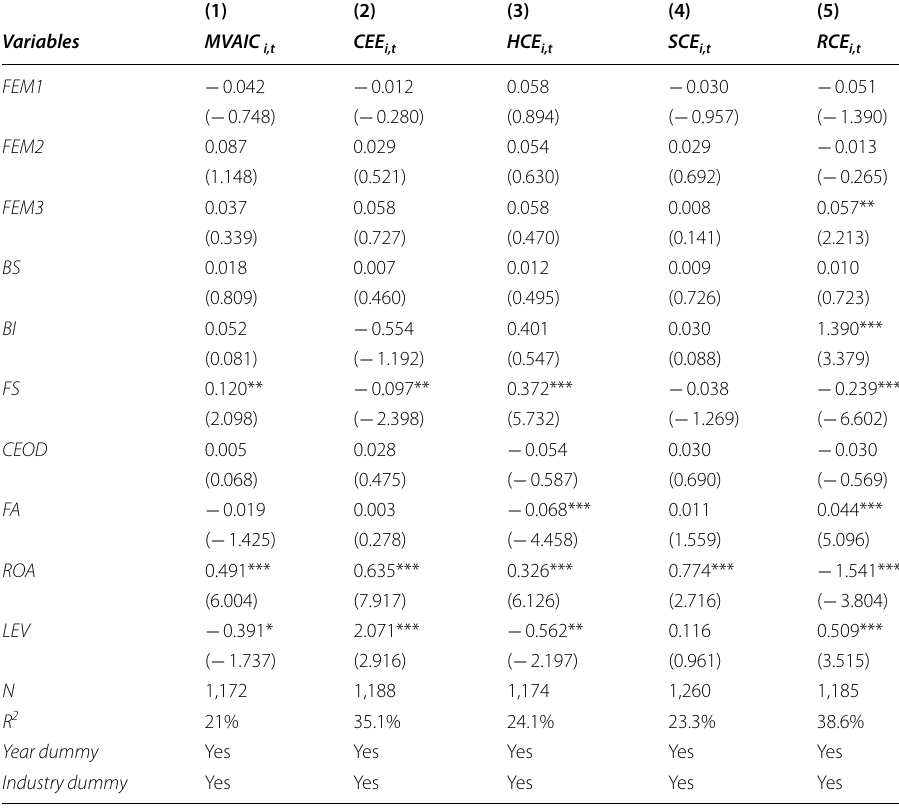
The t-values are given in parentheses. ***, **, and * denotes significance at 1%, 5%, and 10%, respectively. Variable definitions are provided in Table